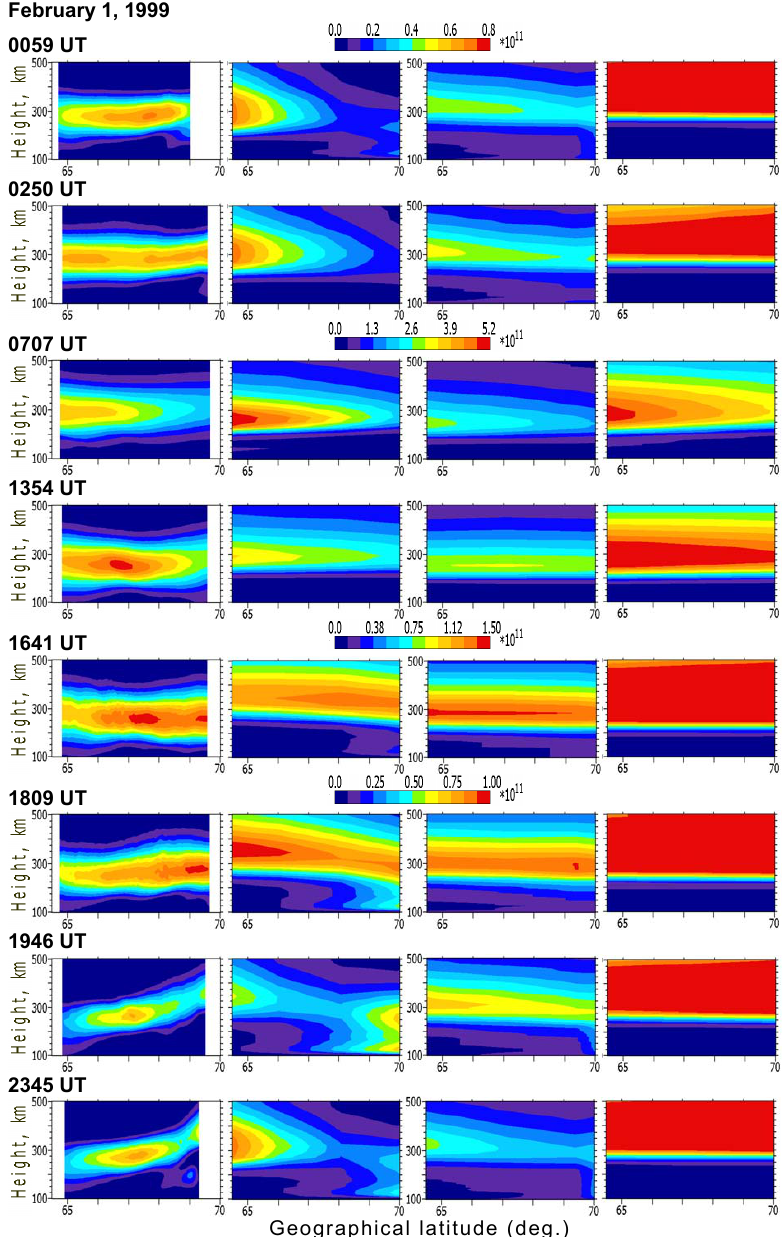
Fig. 5. Same as Fig. 3, on 1 February